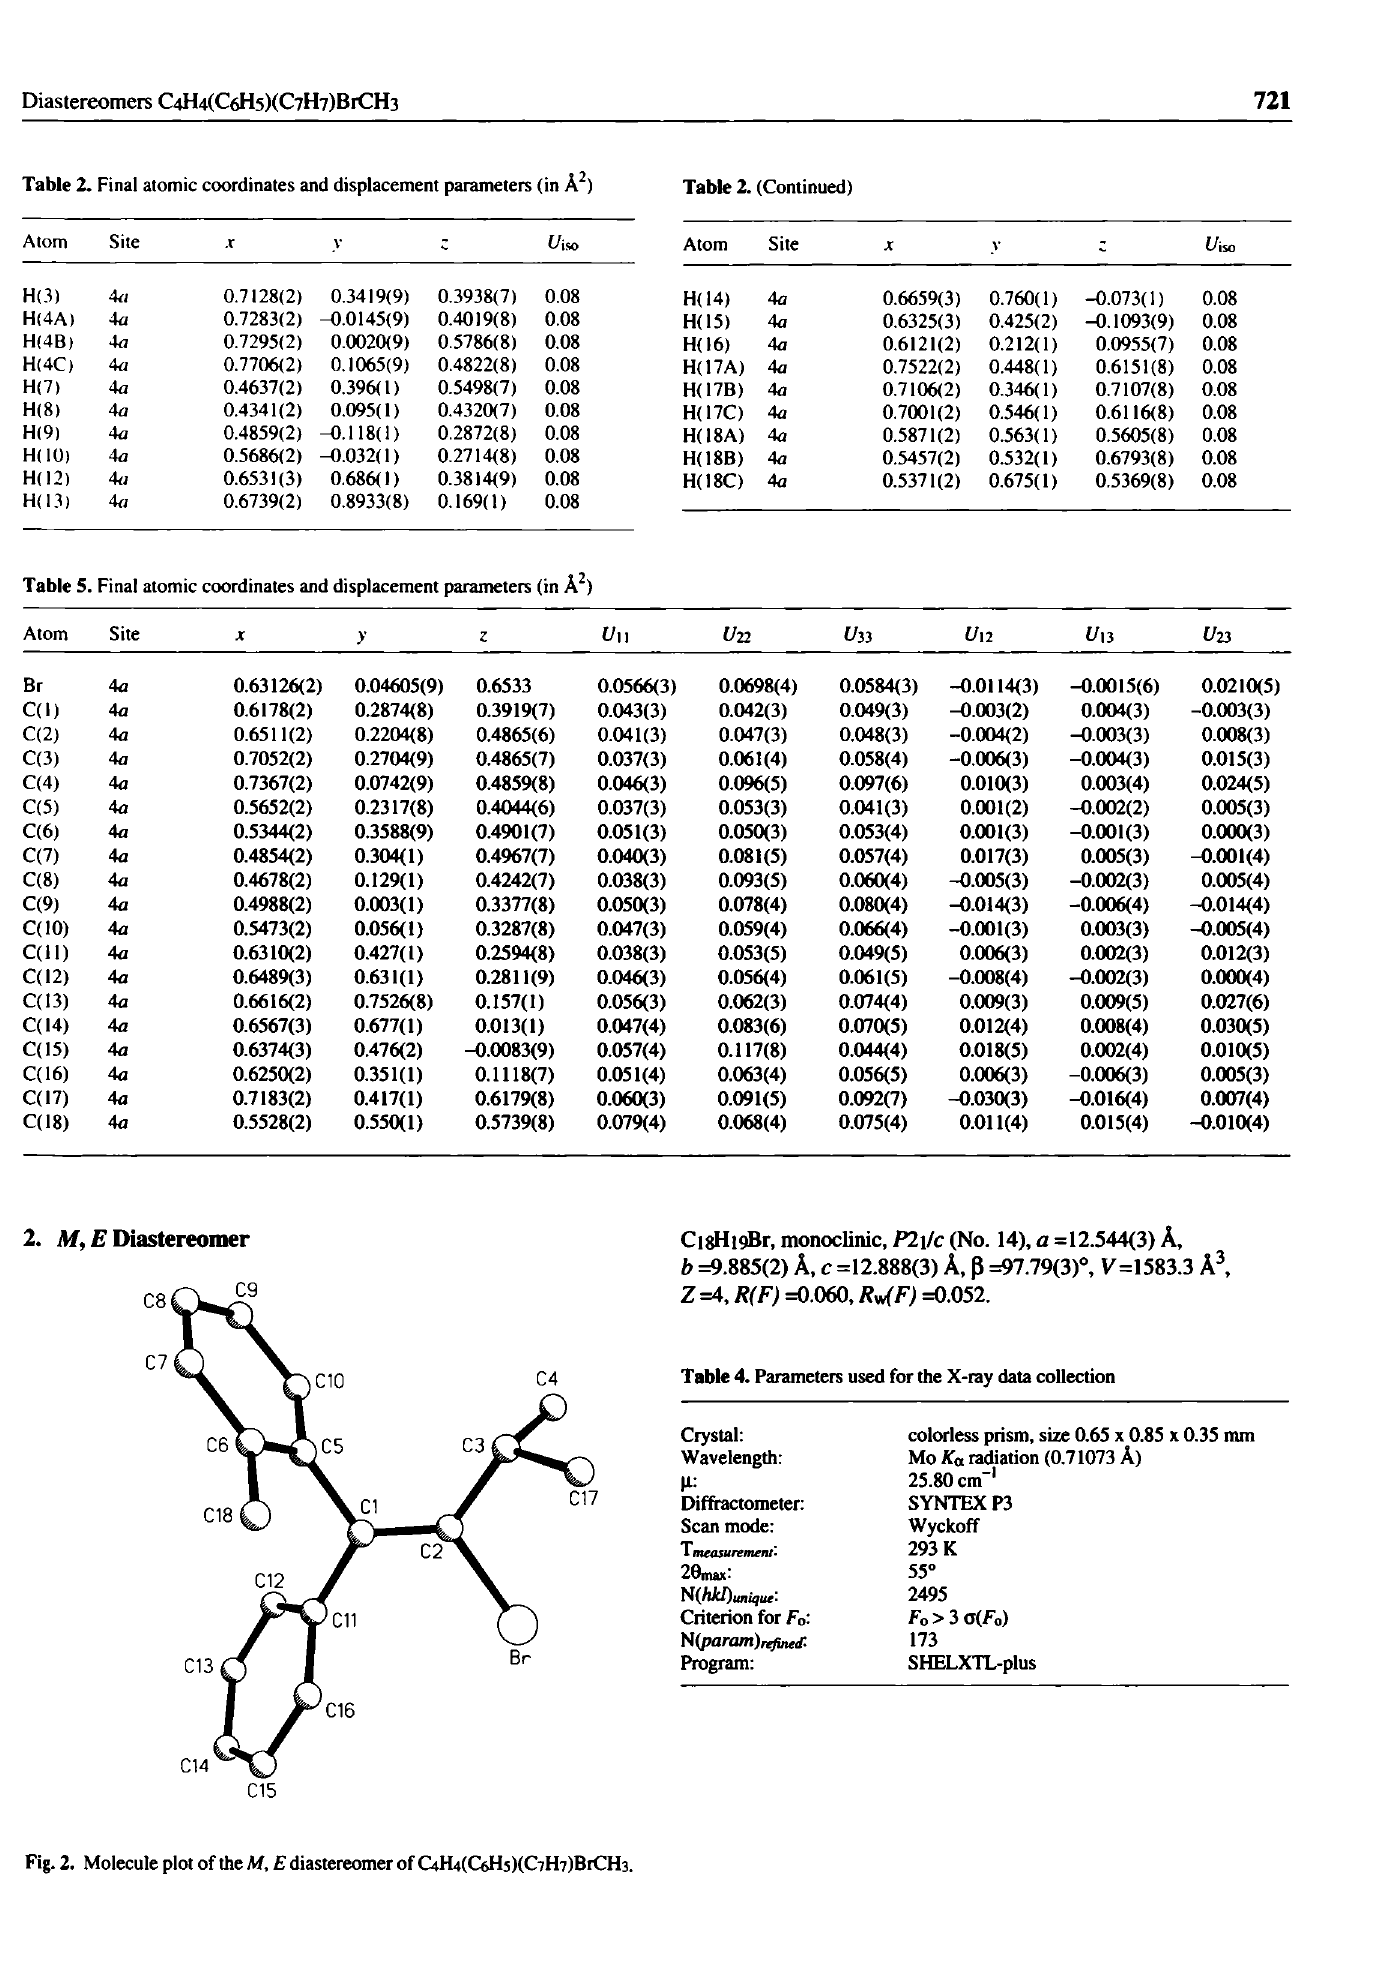
Table 2. Final atomic coordinates and displacement parameters (in Â^) Table 2. (Continued)